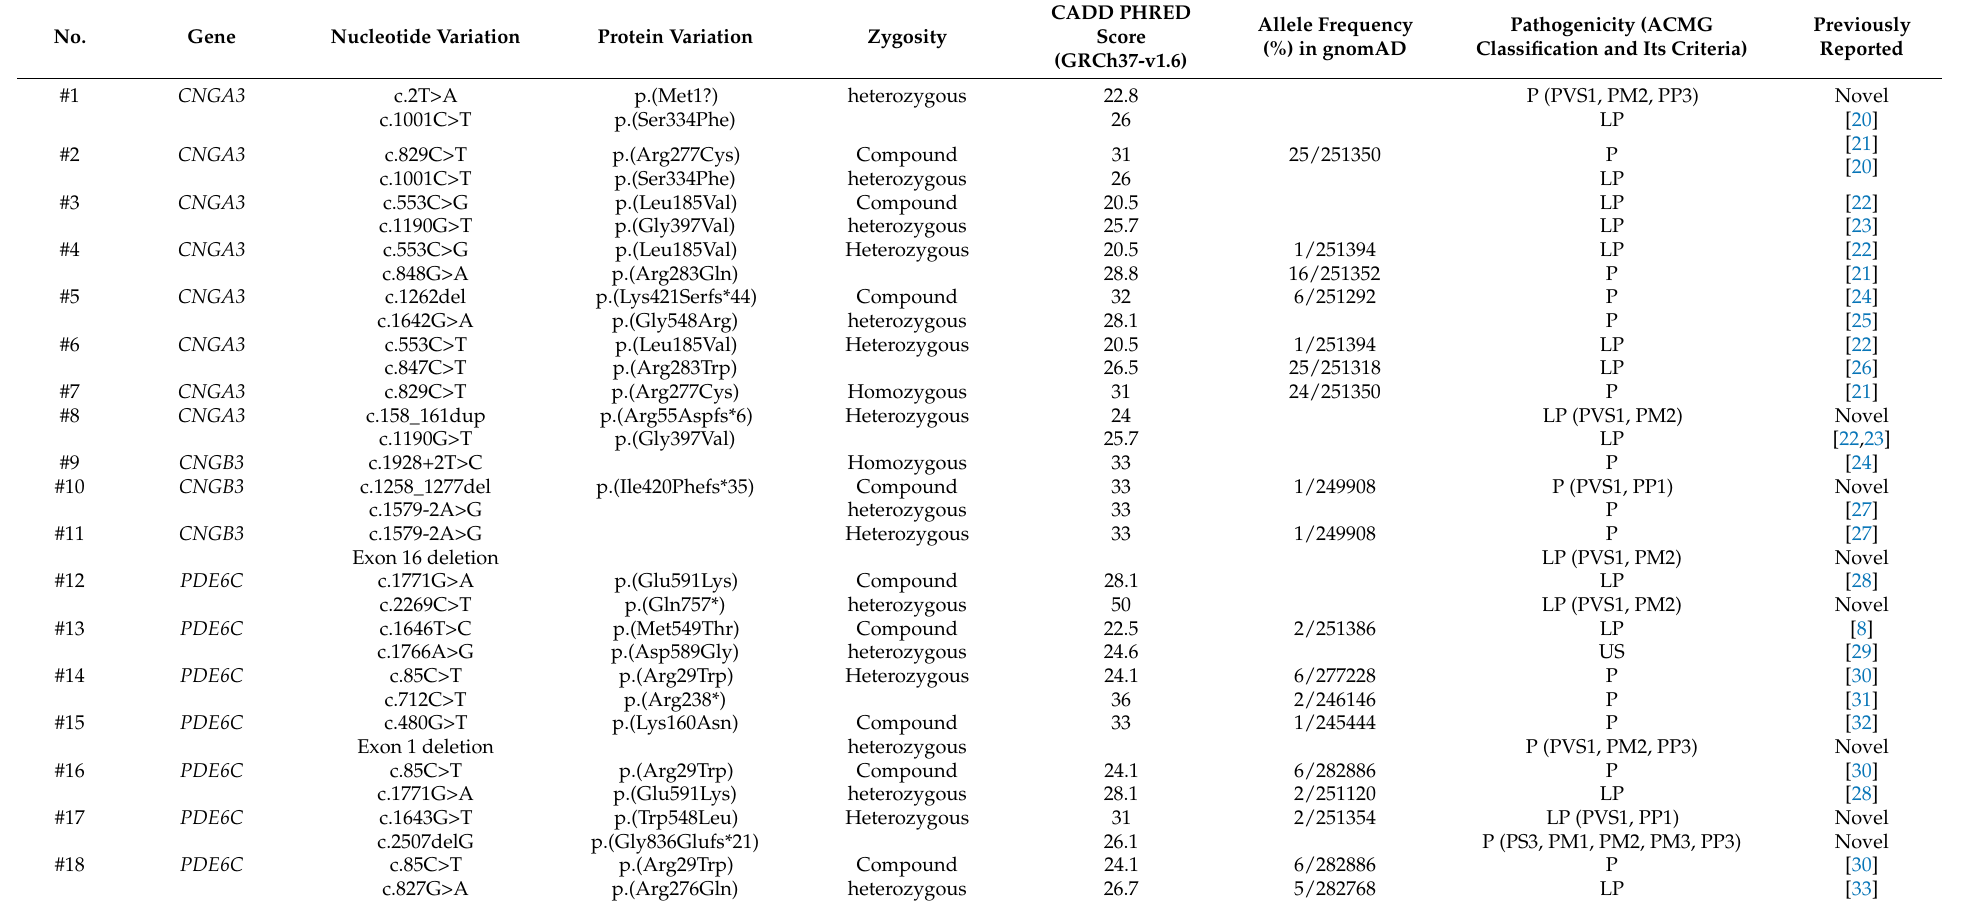
Table 3. Genetic